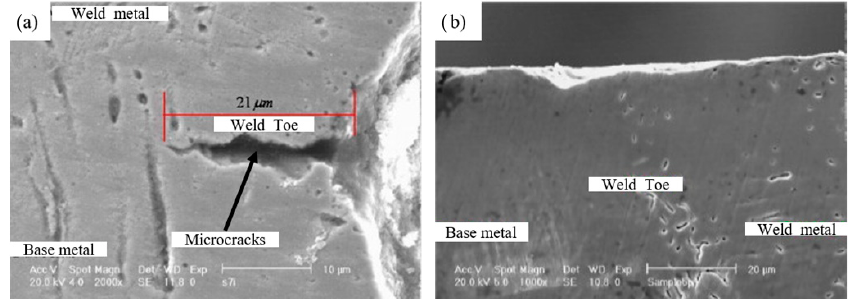
Figure 7. SEM of SS 304 sheets ( a ) microcracks in weld toe; ( b ) after UIP treatment closure of microcracks and modified weld toe curvature. Reproduced with permission from [39]. Copyright Elsevier,